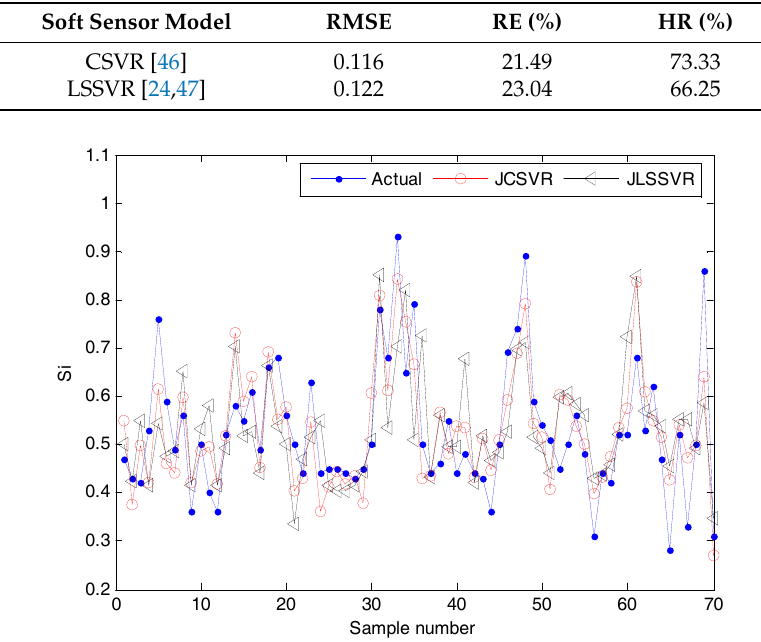
Table 1. Fitting results comparison of CSVR and LSSVR soft sensor models for the training set.